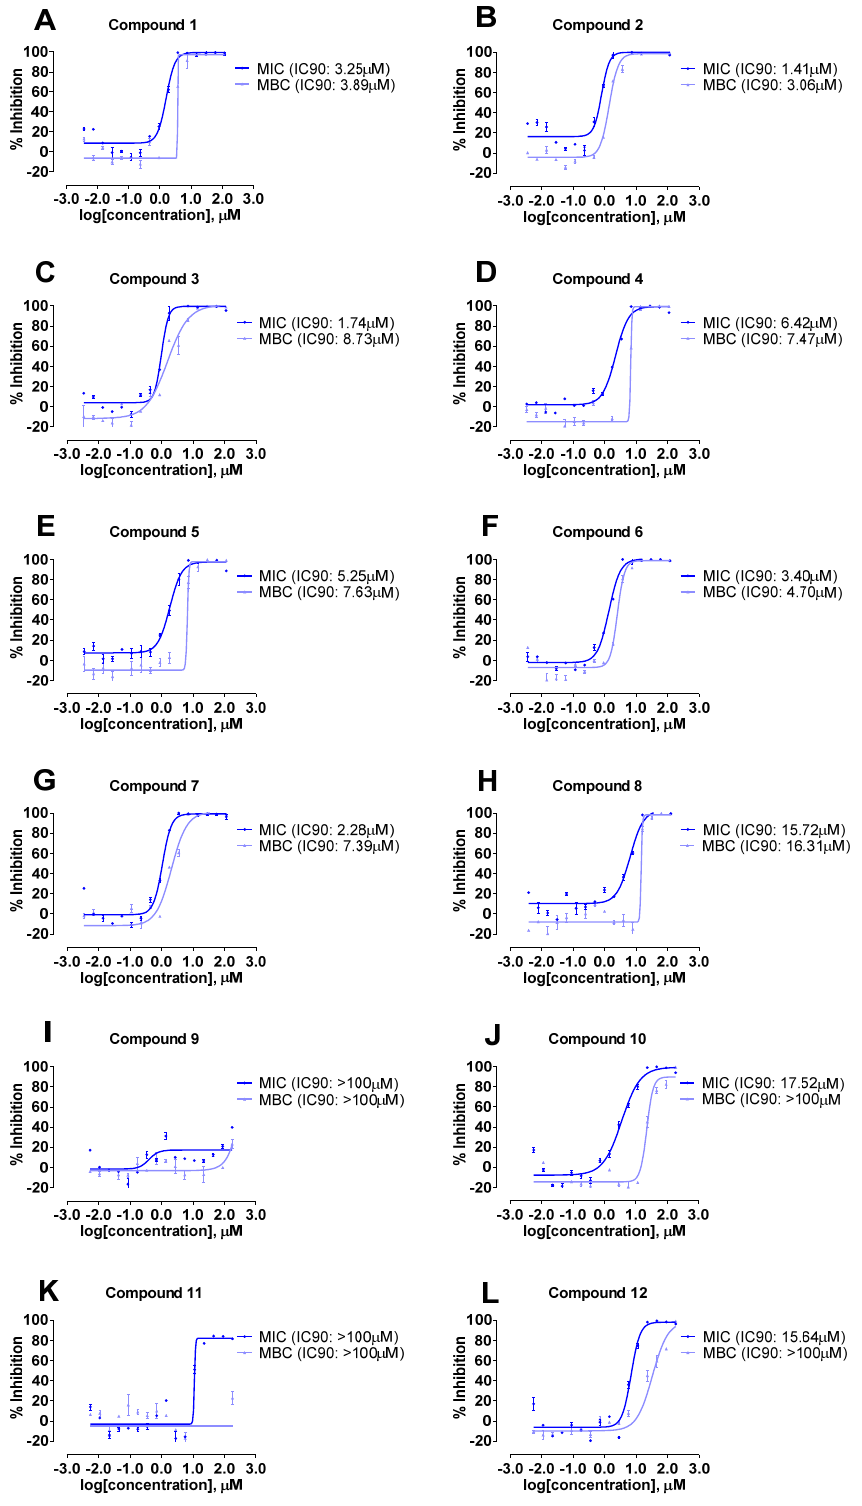
Figure 9. Inhibitory effect dose–response curve against S. aureus Rosenbach (ATCC ® 25923™) for compounds 1 – 12 ( A – L ).